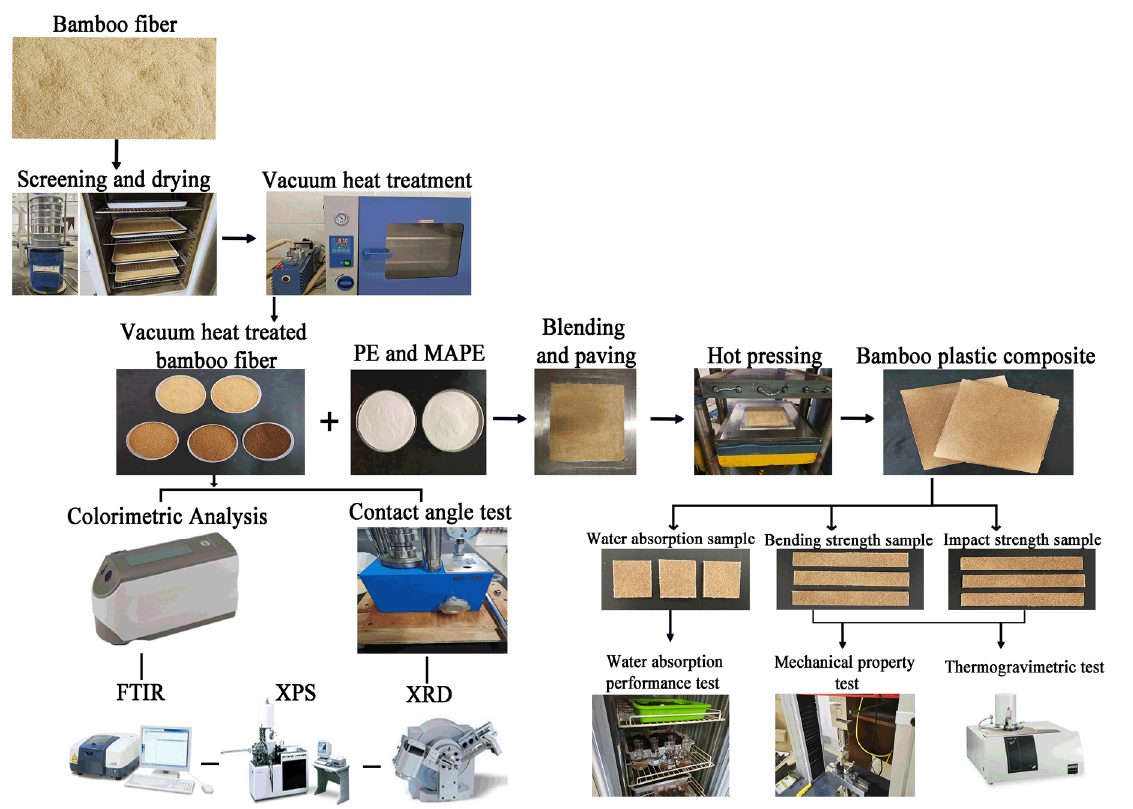
Figure 1. The preparation flow chart of vacuum heat-treated bamboo fiber/polyethylene composites.